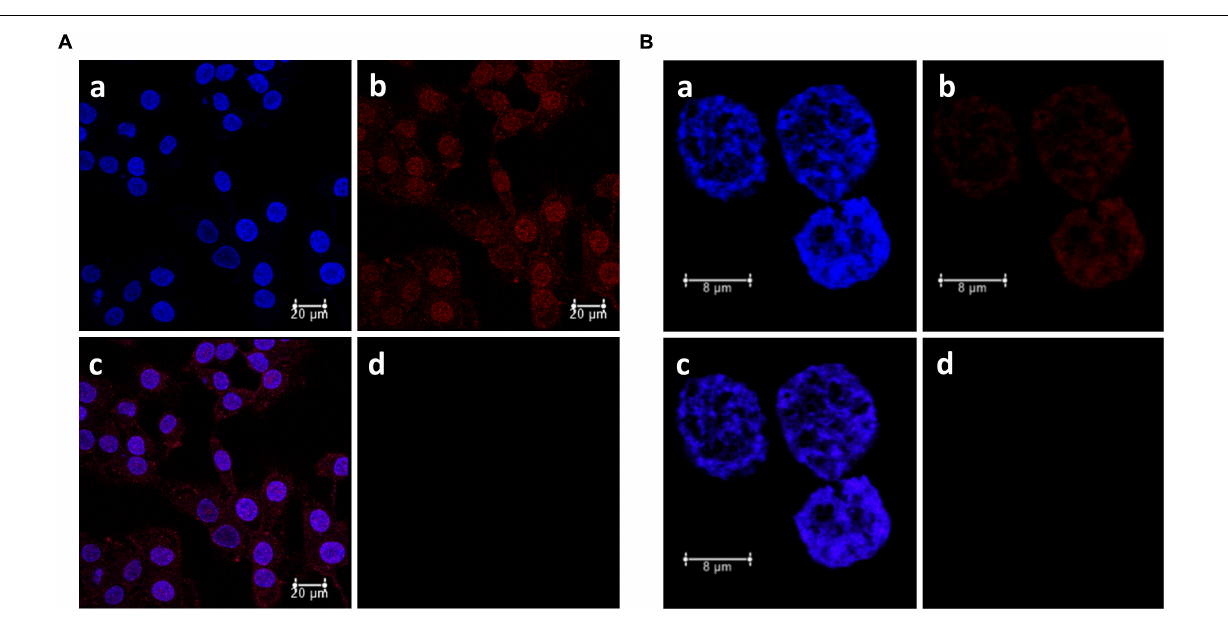
FIGURE 8 | Subcellular localization of porphyrin ( P ) in bladder cancer cells T24 determined by confocal laser scanning microscopy. (A) P-HNP uptake. (B) Free P uptake. a: DAPI (blue fluorescence), b: porphyrin (red fluorescence), c: merged, d: control (untreated cells + DAPI, emission 630–710 nm). T24 cells were incubated sequentially with P or P-HNP for 30 min and marked with DAPI (nucleus